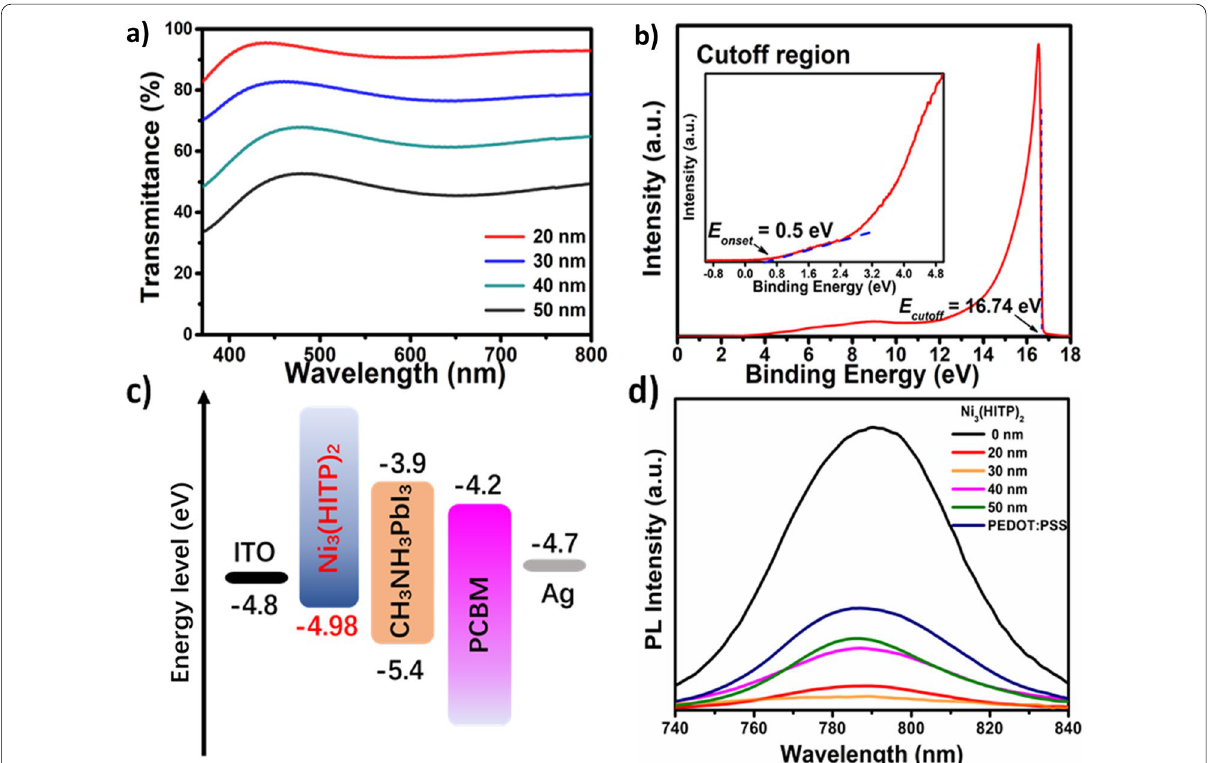
Fig. 2 Characterization of optical and electrical properties of Ni 3 (HITP) 2 film. a Optical transmission spectra of different thickness of Ni 3 (HITP) 2 films; b UPS spectra of Ni 3 (HITP) 2 film; c Energy level alignment diagram of PSCs and d The steady-state PL spectra of perovskite films on different thickness